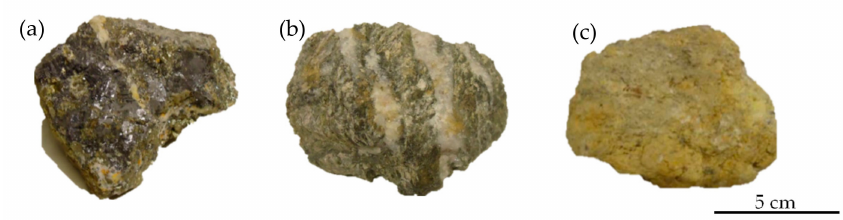
Figure 1. Photographs of some of the analysed rock chip samples, ( a ) ore that consists of the sulphide minerals (e.g., galena, pyrite and sphalerite); ( b ) host rock—banded gneiss; and ( c ) the weathered material (e.g., clay